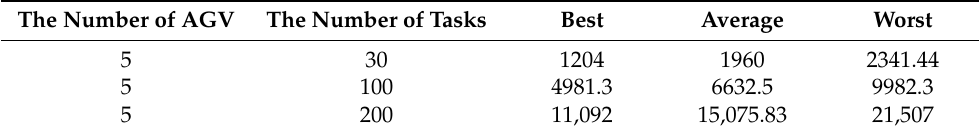
Table 8. The Computational Complexity of the proposed